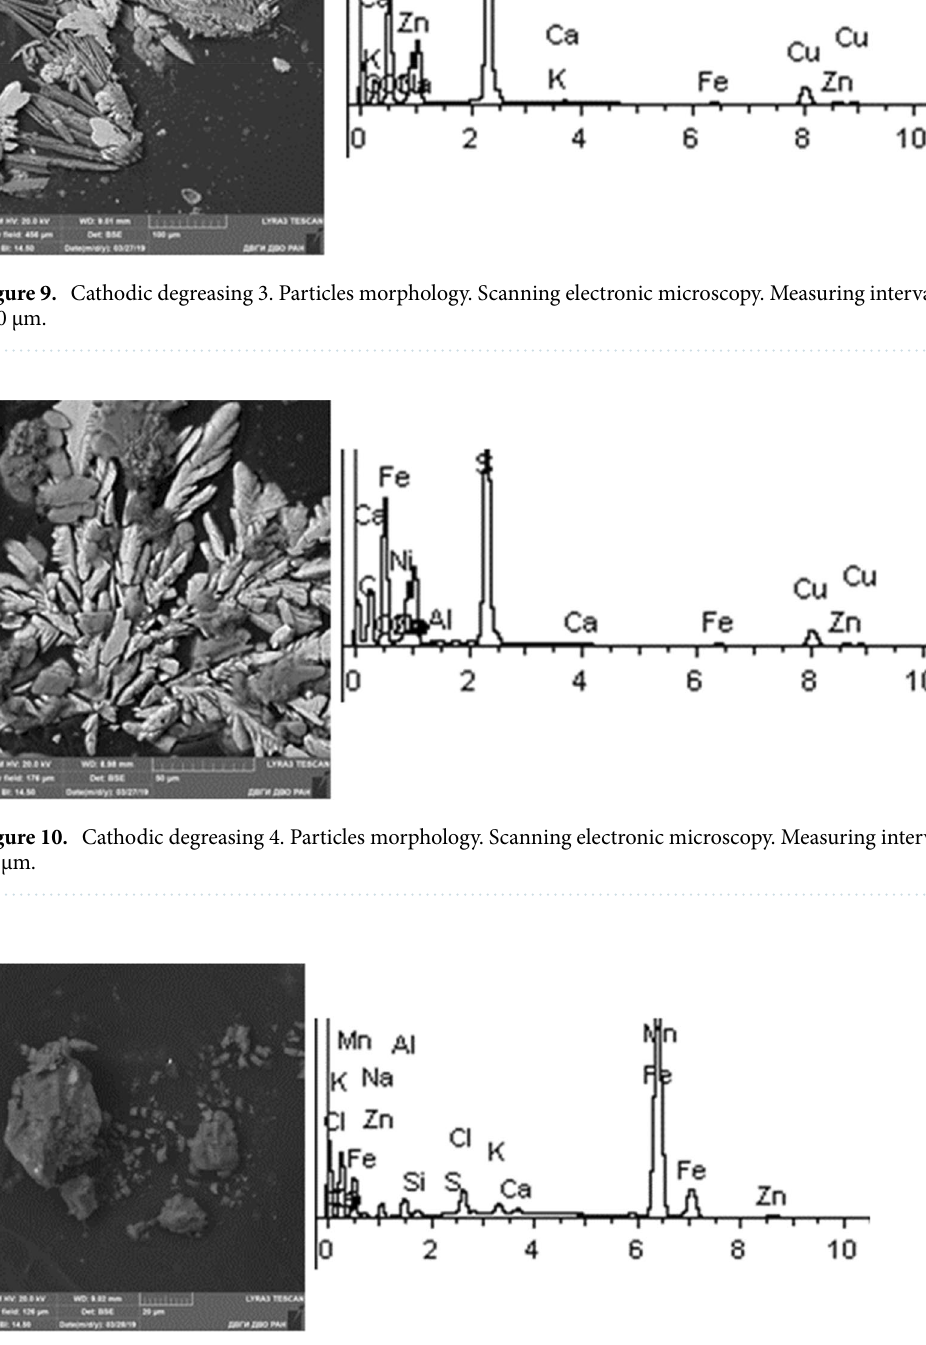
Figure 11. Cold rinse. Particles morphology. Scanning electronic microscopy. Measuring interval 20